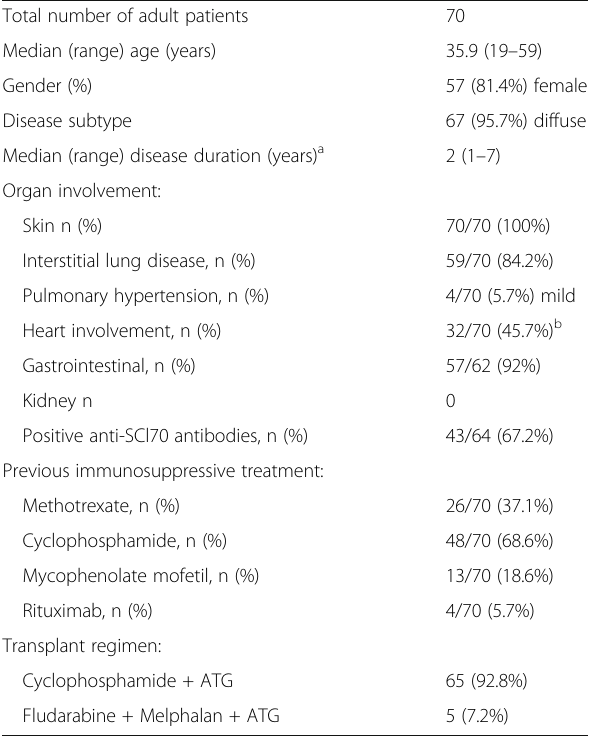
Table 1 Patient baseline characteristics and transplant details Total number of adult